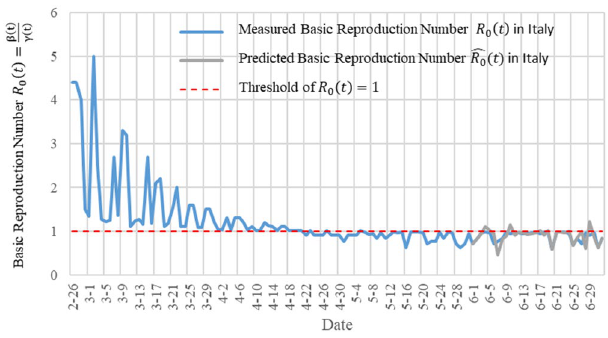
t ) in Italy measured by the TW-SIR prediction R 0 ( (cid:31)